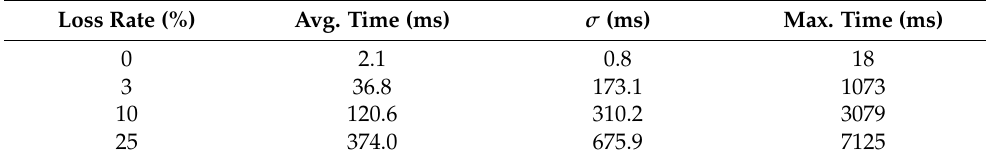
Table 4. HTTP/3 adoption rate and connection establishment time with packet loss settings. (Alt-Svc). Loss Rate